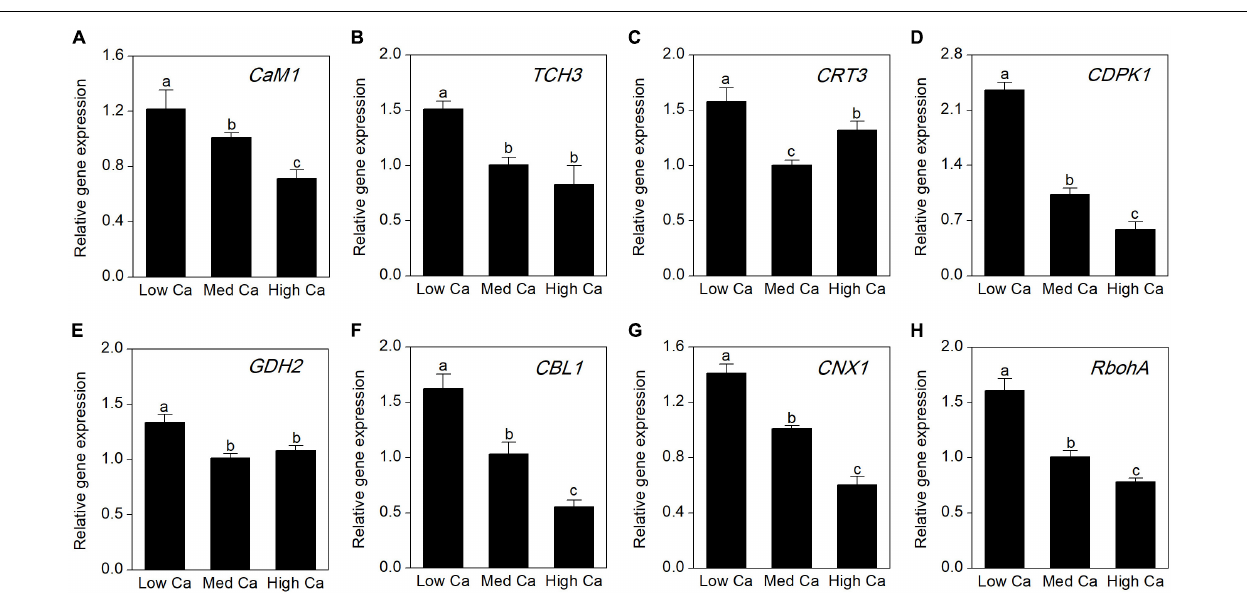
FIGURE 7 | Expression analysis by qRT-PCR of eight Ca-related genes in T. wallichiana var. mairei treated at different Ca levels under AR stress. (A) Calmodulin 1 ( CaM1 ), (B) touch 3 gene ( TCH3 ), (C) calreticulin 3 gene ( CRT3 ), (D) calcium-dependent protein kinase 1 ( CDPK1 ), (E) glutamate dehydrogenase 2 gene ( GDH2 ), (F) calcineurin B-like calcium sensor protein 1 gene ( CBL1 ), (G) calnexin 1 gene ( CNX1 ), (H) respiratory burst oxidase homolog A gene ( RbohA ). Bars represent the mean value ± SE ( n = 3). Bars with different letters are significantly different from each other ( p <